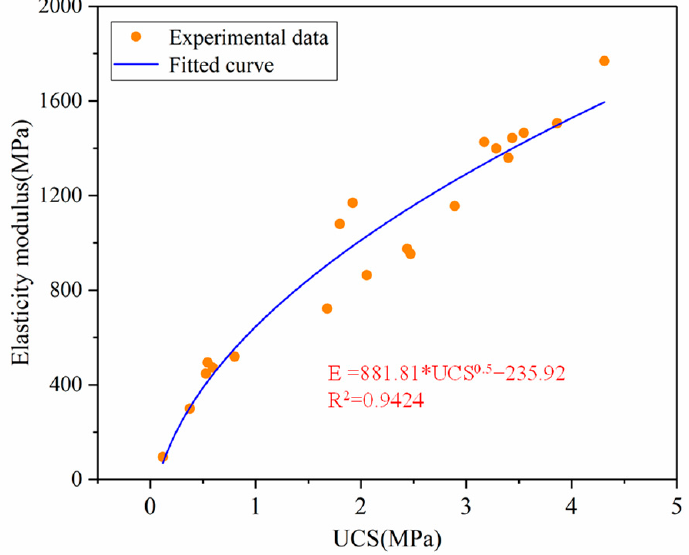
Figure 8. Fi tt ing relationship between elastic modulus and UCS of PCCPB. Figure 8. Fitting relationship between elastic modulus and UCS of PCCPB. The fit coefficient R 2 = 0.9424 indicates that a quadratic function using the UCS’s square root is consistent with the inspired relationship between the EM and the UCS of the PCCPB.